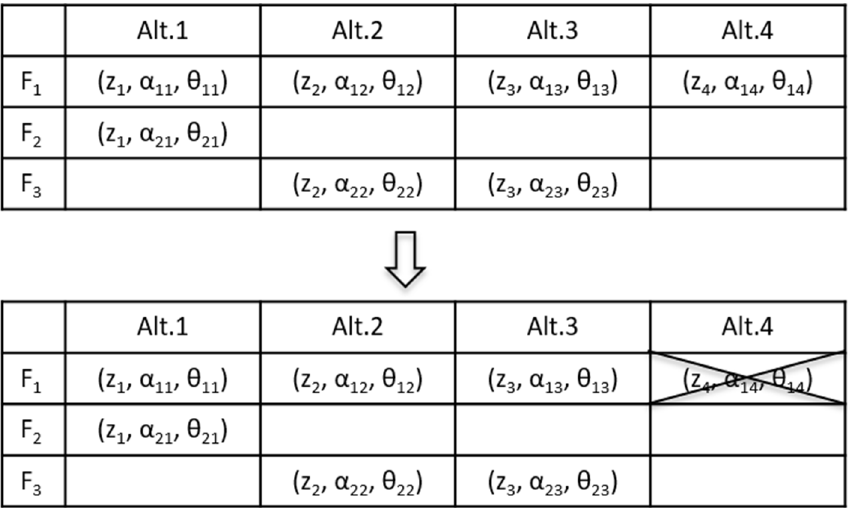
Figure 27. Early virtual illustration example of the 3D scene in IPS LR application for task planning.